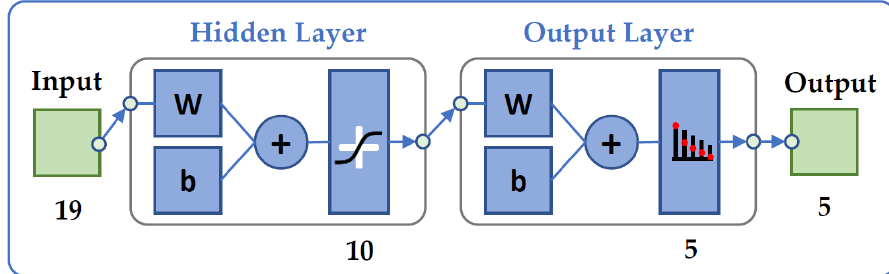
Figure 5. Model architecture for Phase